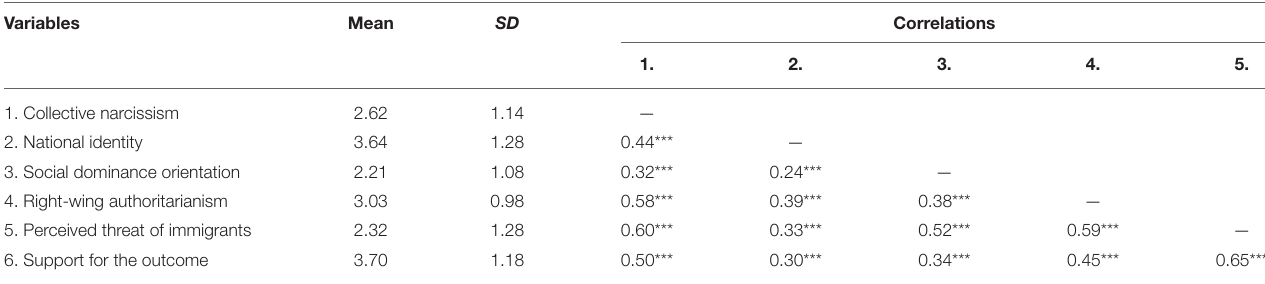
TABLE 1 | Descriptive statistics and correlations for the measurements of Study 1, N = 280.